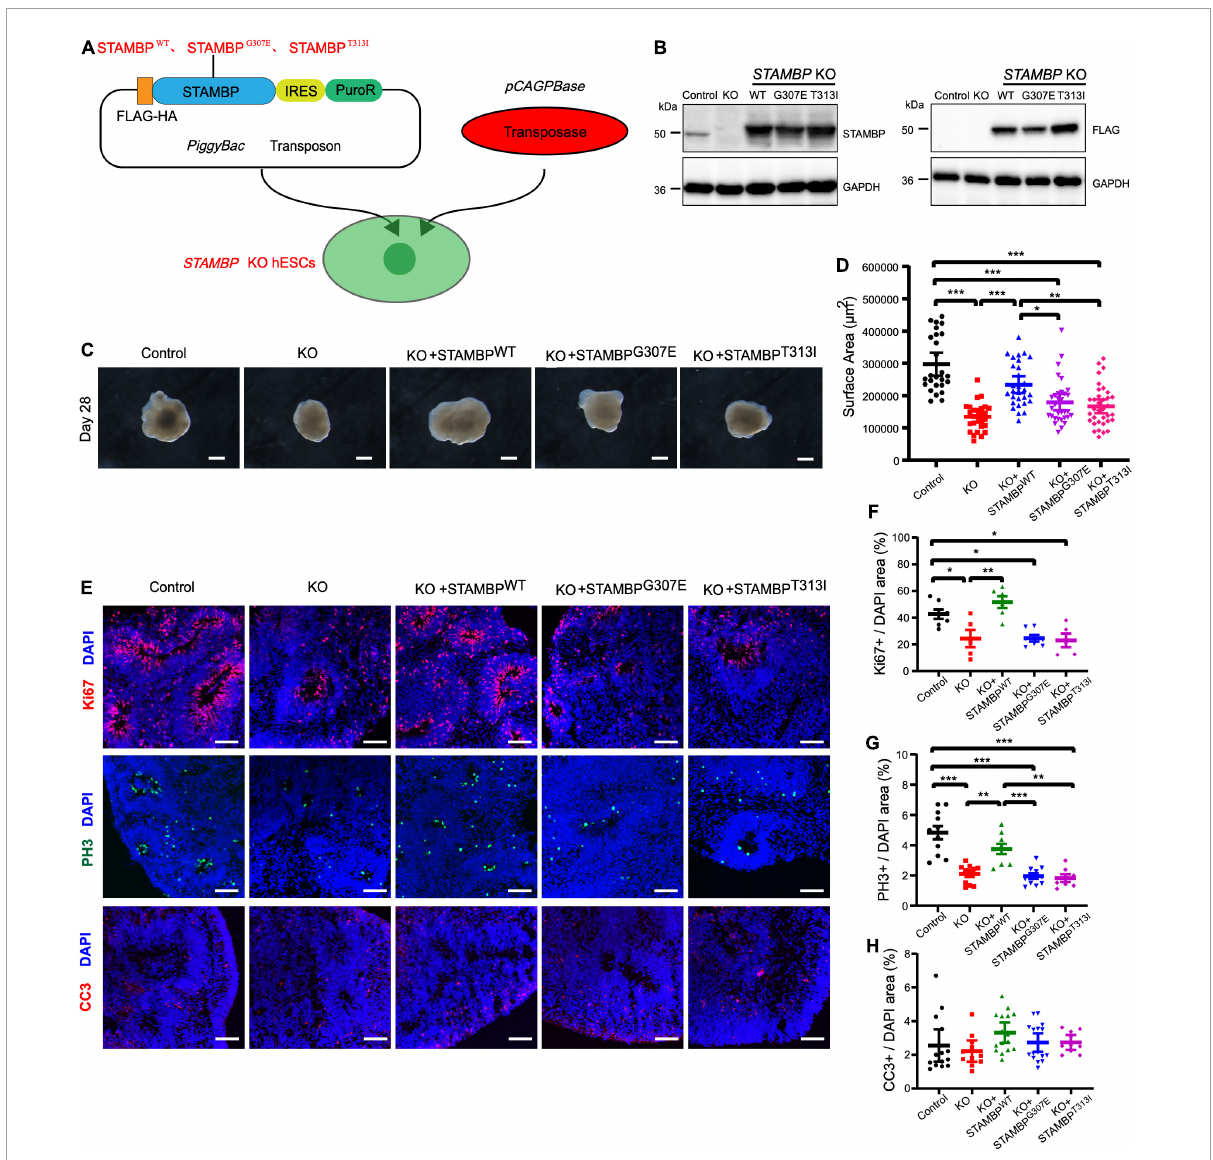
FIGURE5 STAMBP WT but not STAMBP G 307 E and STAMBP T 313 I overexpression rescues the phenotypes of reduced cortical size and impaired proliferation of NSCs. (A) Schematic representation of the PiggyBac-mediated STAMBP expression system. (B) Western blotting confirmed the presence of STAMBP WT , STAMBP G 307 E , and STAMBP T 313 I protein generated from the STAMBP KO hESCs. (C) Representative images of control, STAMBP KO cortical organoids, and organoids generated from STAMBP WT , STAMBP G 307 E , and STAMBP T 313 I overexpression on day 28. Scale bars, 200 µ m. (D) Quantification of surface areas of cortical organoids. Each plot represented an individual organoid. Experiments were repeated three times. Groups were compared using a Kruskal–Wallis ANOVA with Dunn’s multiple comparisons tests. Data are presented as median ± 95% confidence interval, * p < 0.05, ** p < 0.01, *** p < 0.001. (E) Immunofluorescent staining was performed on organoids on day 28. Sections were stained with Ki67 (the first row), PH3 (the second row), and CC3 (the third row). Scale bar: 100 µ m. (F–H) Quantification of cell cycling marker Ki67-positive cells (F) , PH3-positive cells (G) , and cell apoptosis marker CC3 (H) . Each plot represented an individual section. Experiments were repeated three times. Data of Ki67 + /DAPI and PH3 + /DAPI were compared using a one-way ANOVA followed by a Dunnett’s multiple comparisons test. Data are shown as mean ± SEM. Data of CC3 + /DAPI were using a Kruskal–Wallis ANOVA with Dunn’s multiple comparisons tests. Data are presented as a median ± 95% confidence interval. * p < 0.05, ** p < 0.01, *** p <